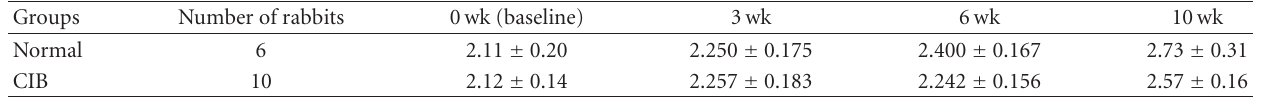
Table 1: Body weight in the two groups (kg) ∗ .